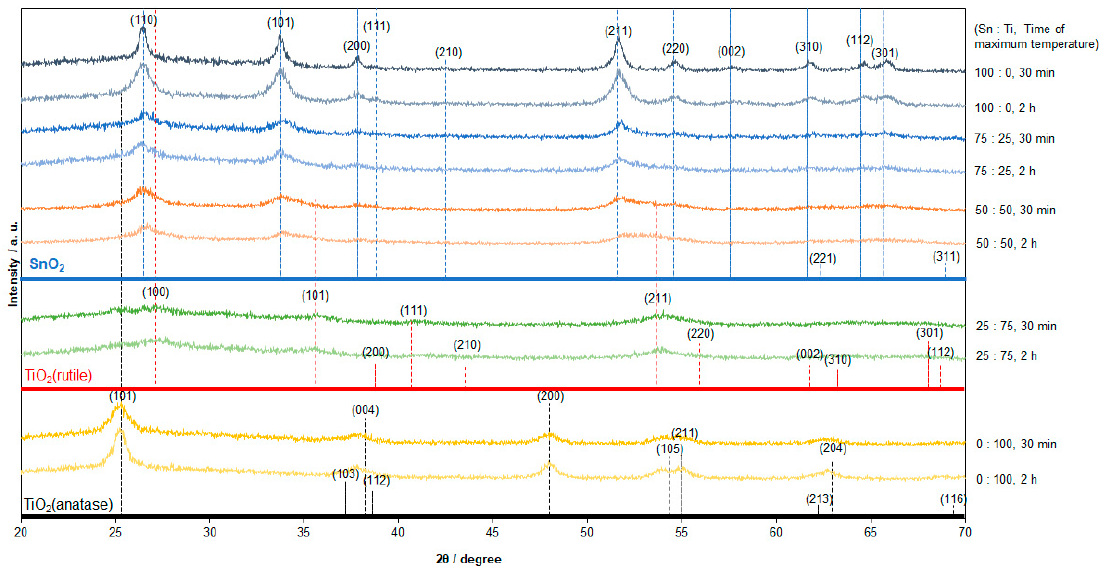
Figure 3. XRD pa tt ern of the sintered Sn/Ti oxide samples at 500 °C in air. The ratios of Sn/Ti in the precursor were 100:0, 75:25, 50:50, 25:75, and 0:100. The database of SnO 2 (blue, JCPDS: 01-077-0452), rutile TiO 2 (red, JCPDS: 01-076-0324), and anatase TiO 2 (blue, JCPDS: 01-075-2550) is also presented. The period of maximum temperature in the sintering was 30 min and 2 h.